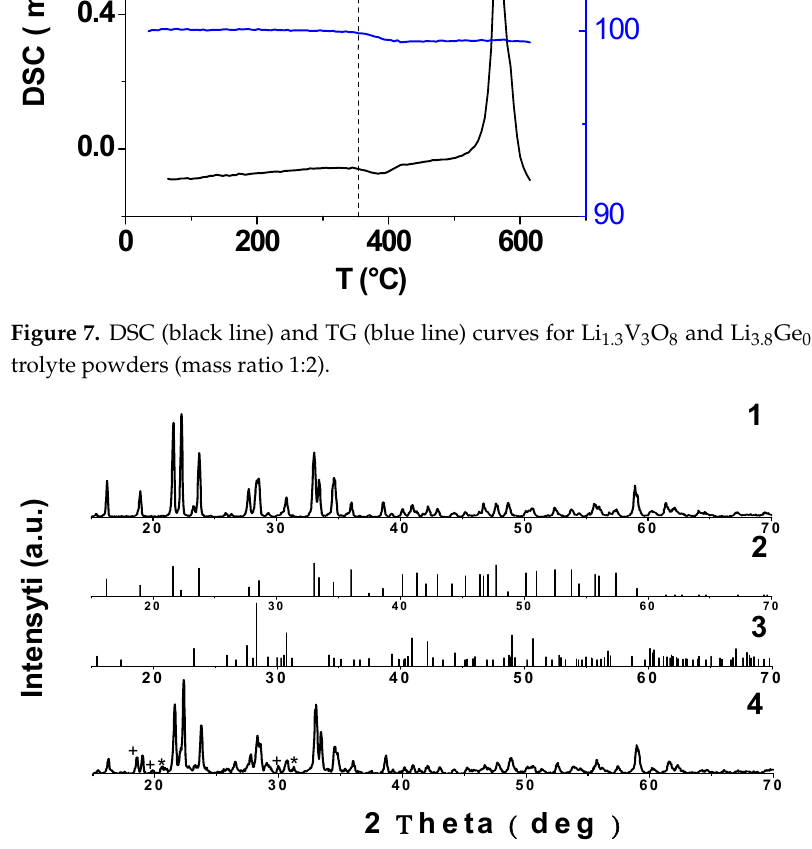
Figure 8. (1) XRD pattern for the mixture of Li 1 . 3 V 3 O 8 and Li 3 . 8 Ge 0 . 9 S 0 . 1 O 4 powders after heat treatment at 300 ° С for 5 h, (2) line diagram of Li 3 . 6 Ge 0 . 8 S 0 . 2 O 4 (PDF-2, № 44-0337),(3) line diagram of LiV 3 O 8 standard (PDF-2, № 72-1193), (4) XRD pattern for the mixture of Li 1 . 3 V 3 O 8 and Li 3 . 8 Ge 0 . 9 S 0 . 1 O 4 powders after heat treatment at 560 ° С for 5 h.